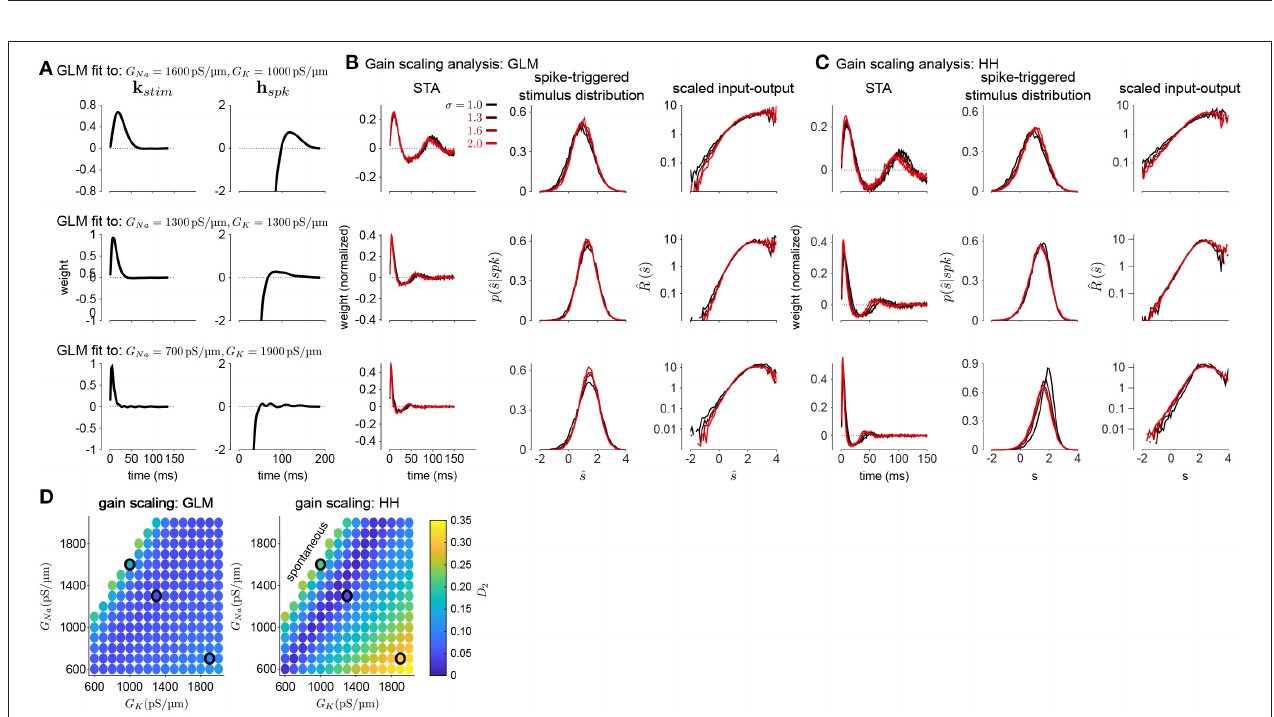
FIGURE 4 | (A) Example filters from GLM fits to HH simulations with three different spiking conductance levels (rows). Large negative values driving the refractory period in the spike history filter (right) have been truncated. (B) The spike-triggered averages (left), scaled spike-triggered stimulus distributions (right), and scaled input-output functions (right) for the GLM fits in A for all four stimulus SDs. (C) Same as B for the HH simulations. (D) Gain scaling ( D 2 from Equation (4), Wasserstein distance between the spike-triggered distributions at σ = 1 and σ = 2) at all the spiking conductance levels explored for the GLM simulations (top) and the Hodgkin-Huxley simulations (bottom). Lower values of D 2 correspond to stronger gain scaling. The three black circles indicate the conductance levels for the GLM examples in A and B. Gain scaling was not computed for values of G Na and G K that resulted in spontaneous spiking in the Hodgkin-Huxley simulations.